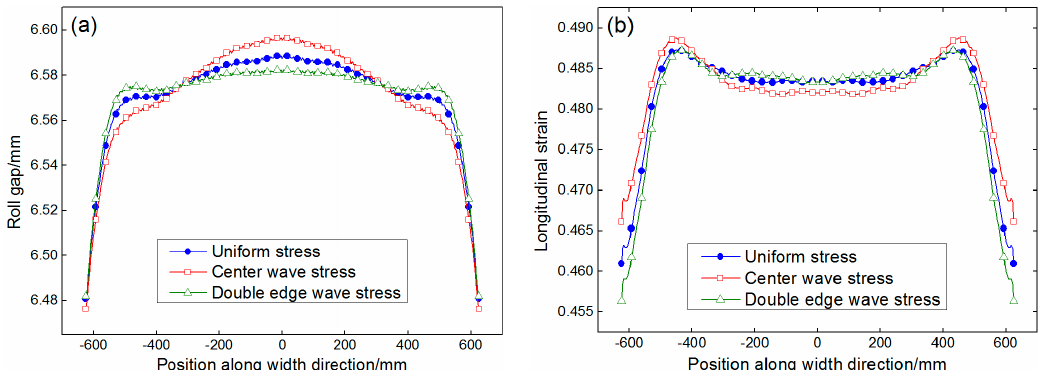
Figure 13. Effect of quadratic wave stress on the roll gap profile and longitudinal strain: ( a ) effect on the roll gap profile; and ( b ) effect on the longitudinal strain.